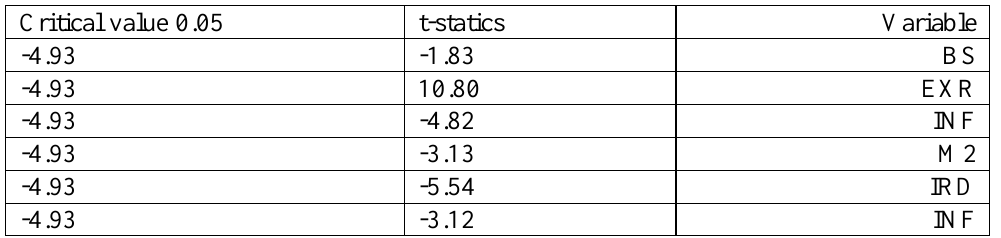
Table 3. zivot Andrews test for